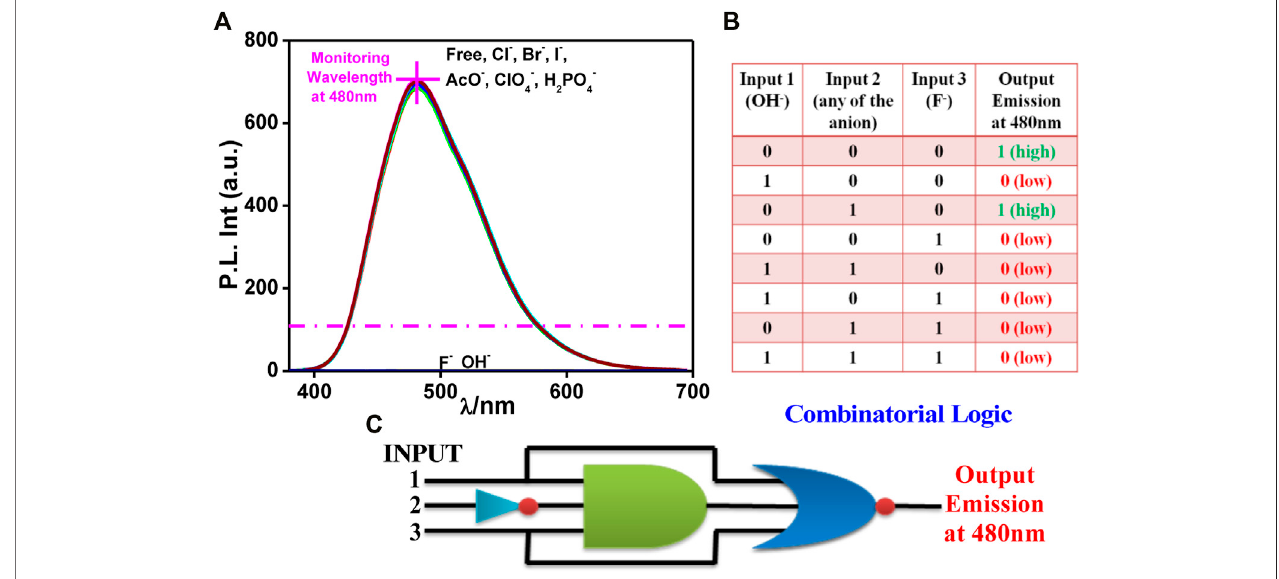
FIGURE 3 | (A) Photoluminescence spectrum of tpy-HImzPh 3 in the presence of different anions. (B) Truth table of the combinatorial logic system. (C) Schematic diagram of the combinatorial logic system.